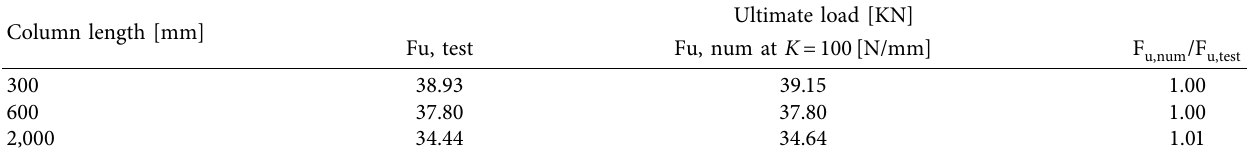
Table 7: Numerical and test ultimate loads of PAC encased elements [26].